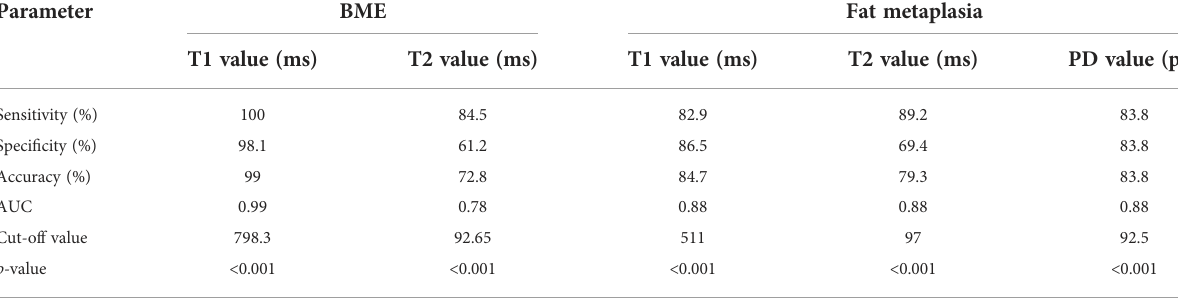
TABLE 5 Diagnostic performance of synthetic magnetic resonance imaging in quantitative analysis of BME and fat metaplasia. Parameter